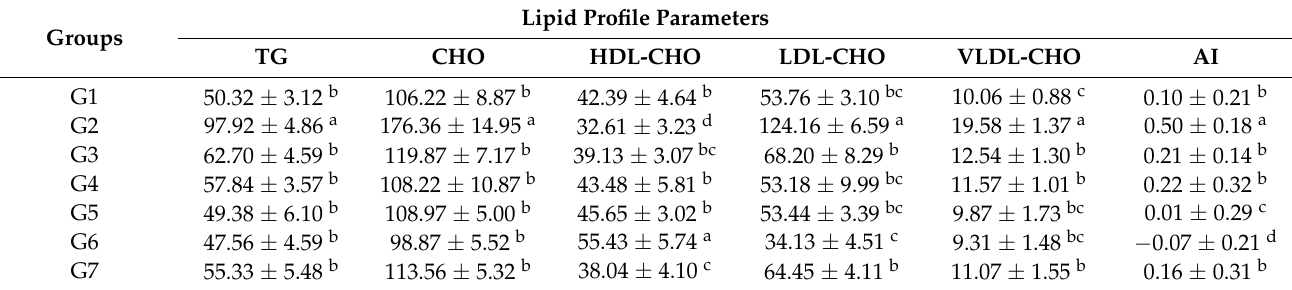
Table 4. Effect of probiotic-enriched FCM combined with S. officinalis on lipid profile and Atherogenic index in STZ-induced diabetes in